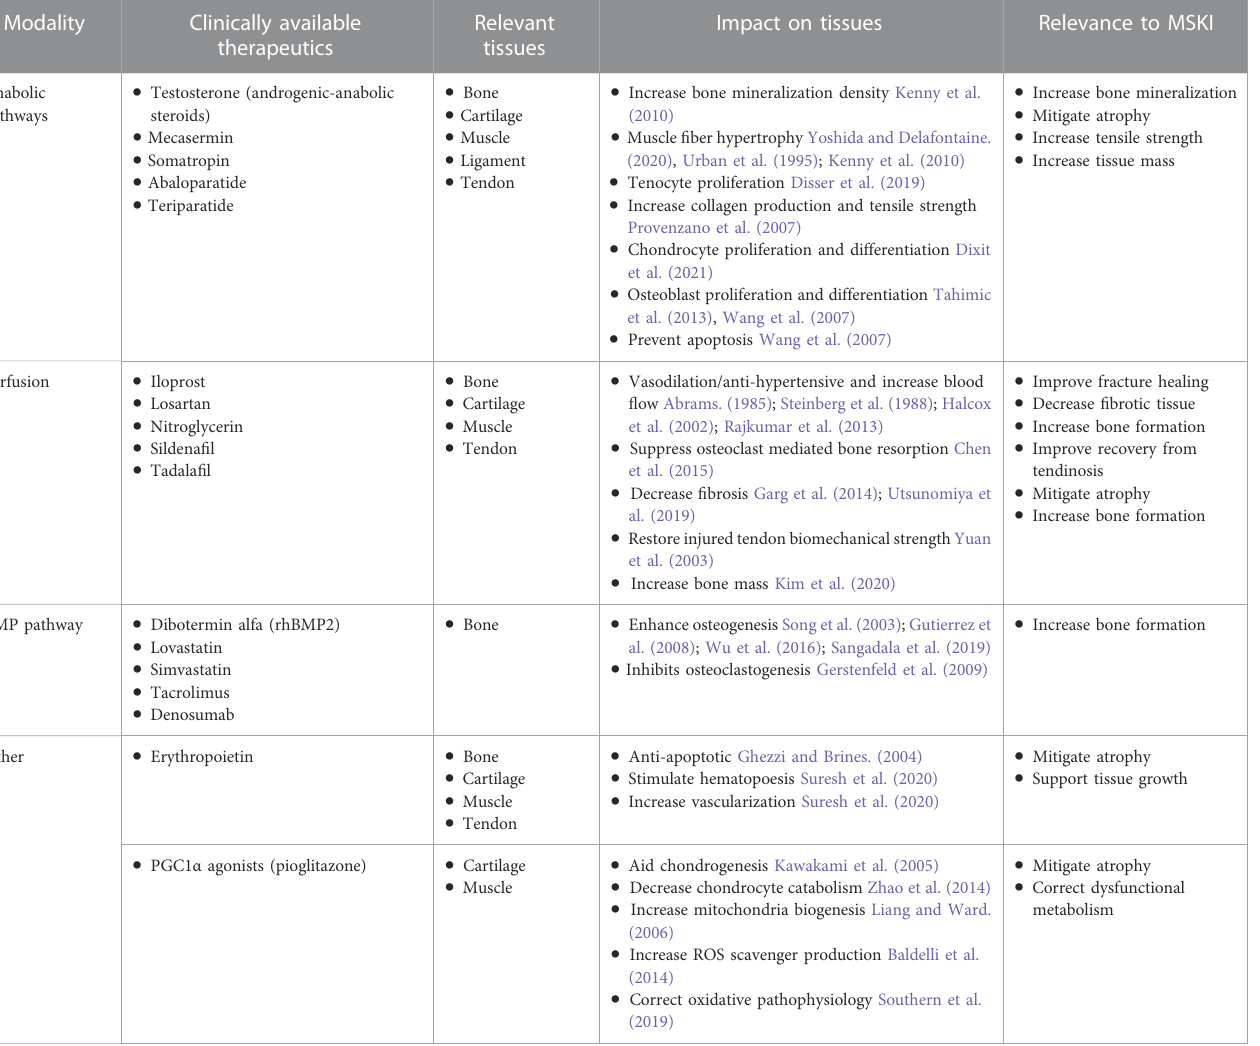
TABLE 1 Examples of existing therapeutics for potential REPAIR utilization. Modality Clinically available